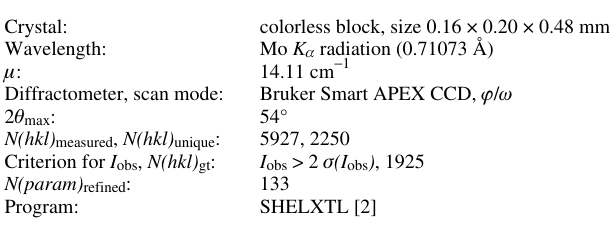
Table 1. Data collection and handling.